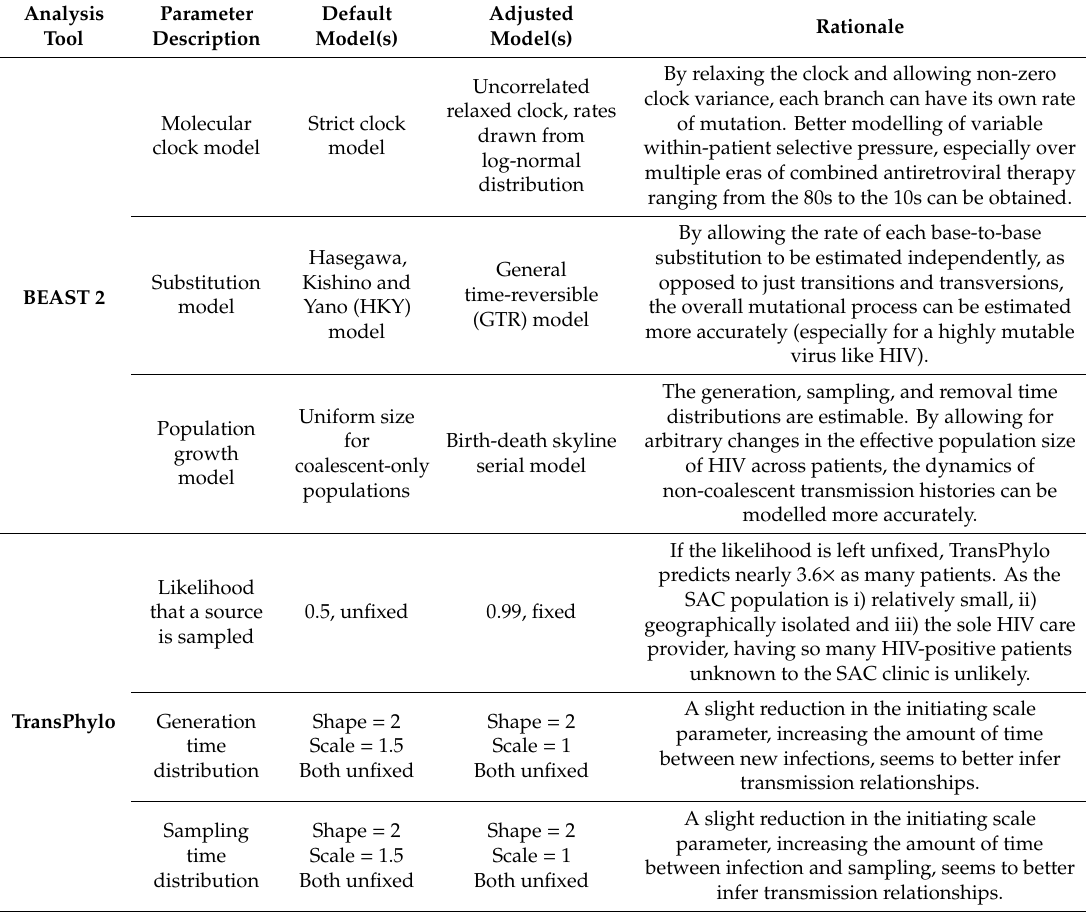
Table 2. Comparison of default and adjusted BEAST2 TransPhylo parameter combinations, and rationale for the choice of adjusted parameter